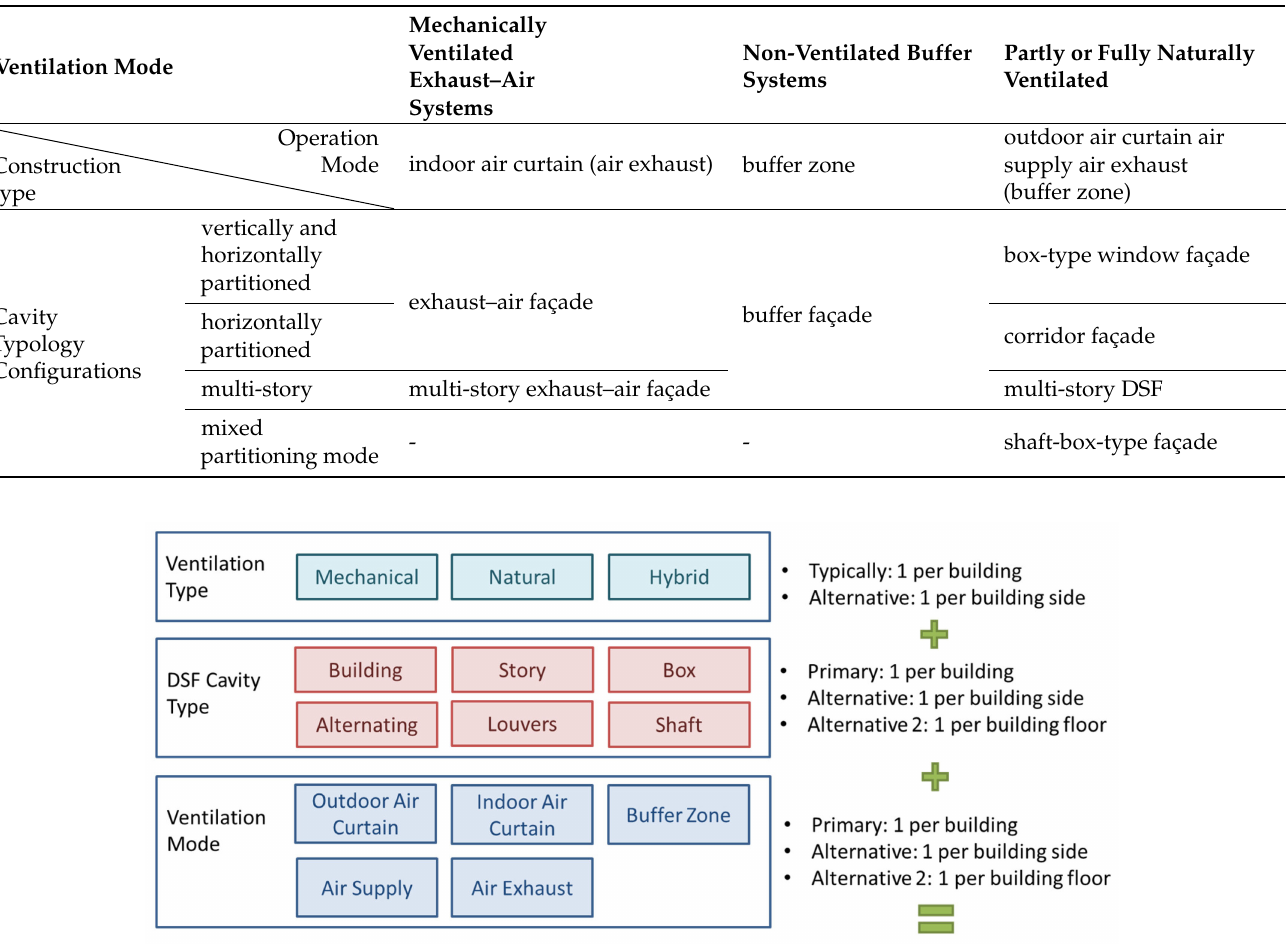
Table 4. DSF System Ventilation Mode Typologies (adapted from Gelesz and Reith [41]).